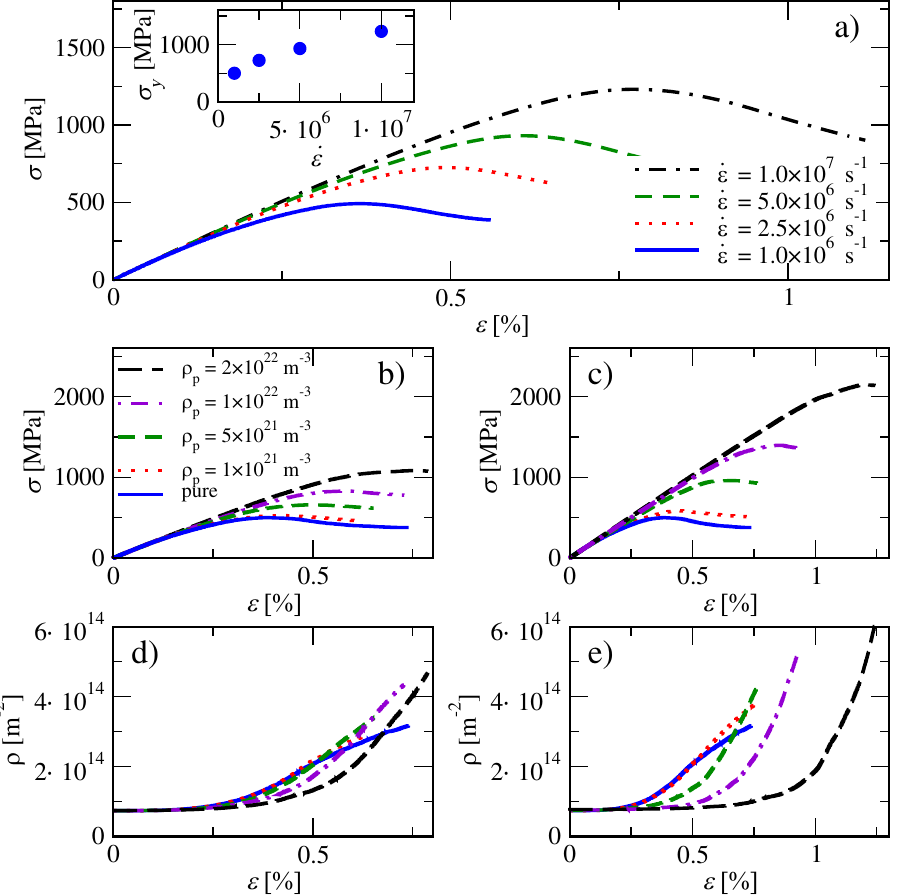
Figure 2. ( a ) Stress-strain curves of pure systems strained with different strain rates ε  . In the inset the yield stress σ y is plotted as a function of ε  . ( b ) Shows stress-strain curves for different precipitate densities ρ p , considering precipitates with the size parameter R p = 5 nm. ( c ) Shows the corresponding stress-strain curves for R p = 10 nm. The evolution of the dislocation density ρ with strain for the same ρ p -values considered above, with R p = 5 nm in ( d ) and R p = 10 nm in ( e ),